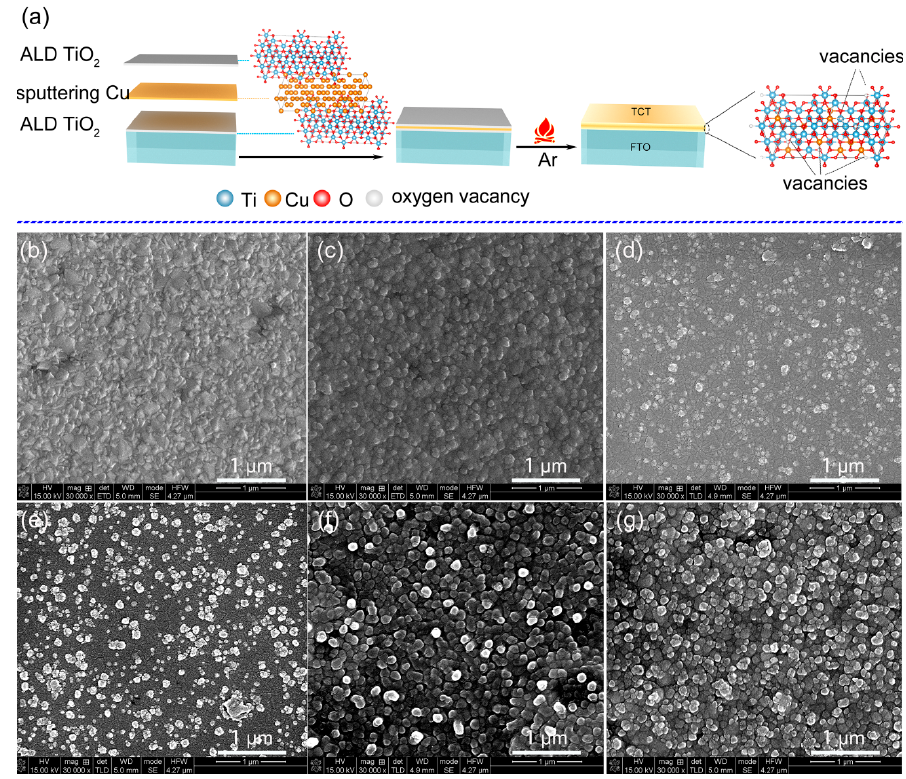
Figure 1. Schematic illustration of preparation process of Cu-doped TiO 2 thin films by Cu reduction ( a ); and SEM images: of FTO glass ( b ); bare TiO 2 ( c ); TCT-1 ( d ); TCT-2 ( e ); TCT-3 ( f ); and TCT-4 ( g ). Table 1. The thicknesses of as-prepared bare TiO 2 and four TCT thin films.